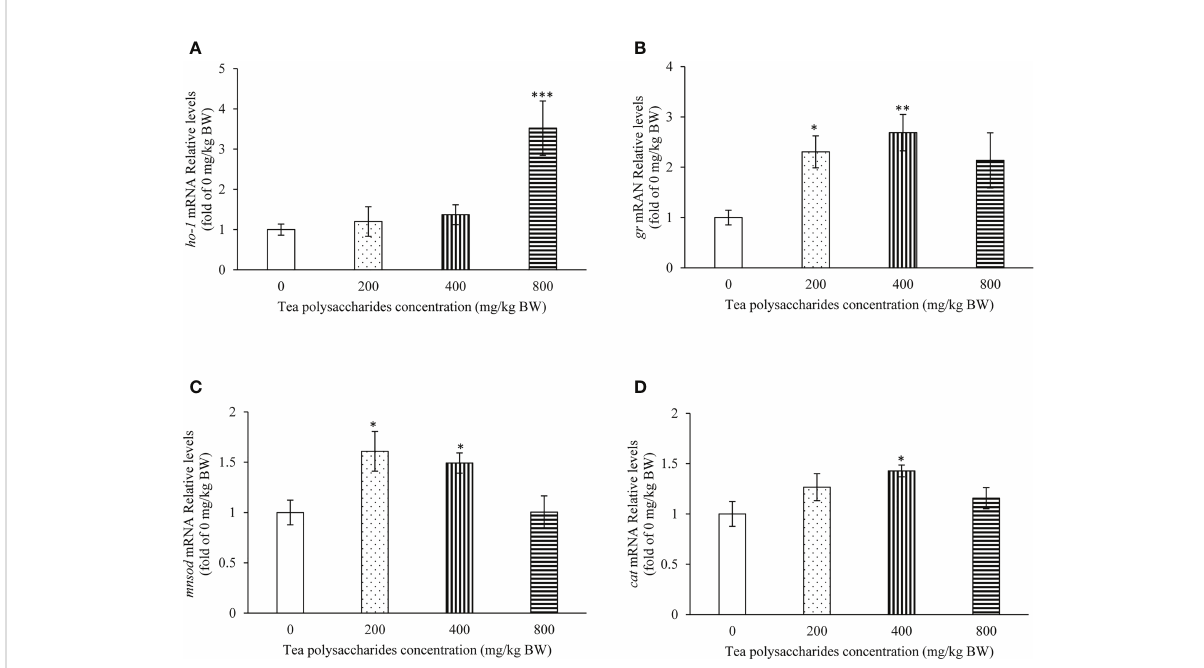
FIGURE 3 Effects of tea polysaccharides on genes expression related to antioxidant capacity in hepatopancreas. (A) ho-1 ; (B) gr ; (C) mnsod ; (D) cat . At end of the experiment, fi sh were killed and the hepatopancreas was collected for RNA extraction and real-time PCR. All data are shown as mean ± S.E.M. (n = 10-12). Signi fi cant differences were indicated by asterisks, *, P < 0.05; **, P < 0.01; ***, P < 0.001.